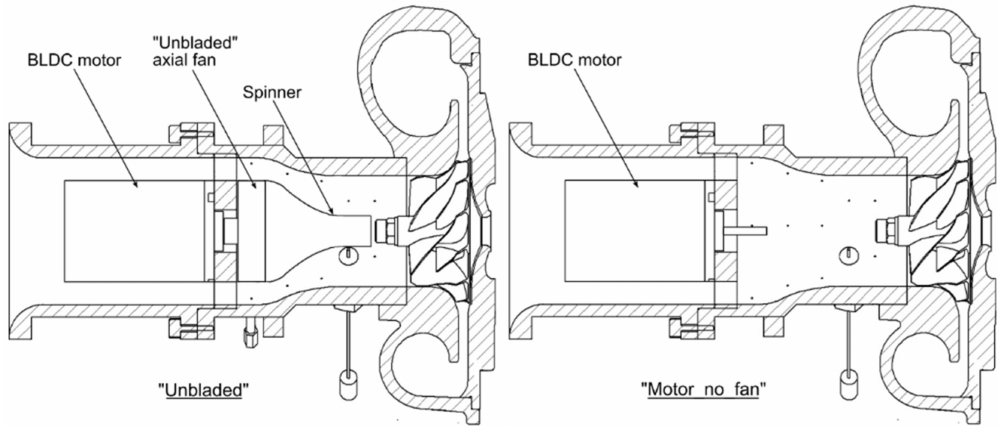
Figure 15. Illustration of “Unbladed” and “Motor_no_fan” system